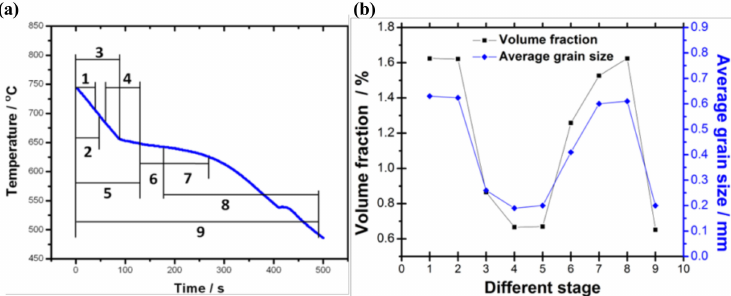
Figure 5. The effect of TMF on the micro-pore fraction and grain size in Al-alloy solidified under different conditions: ( a ) schematic sketch of solidification stages treated with TMF; ( b ) evolution of volume fraction and average grain size in different solidification stages with TMF